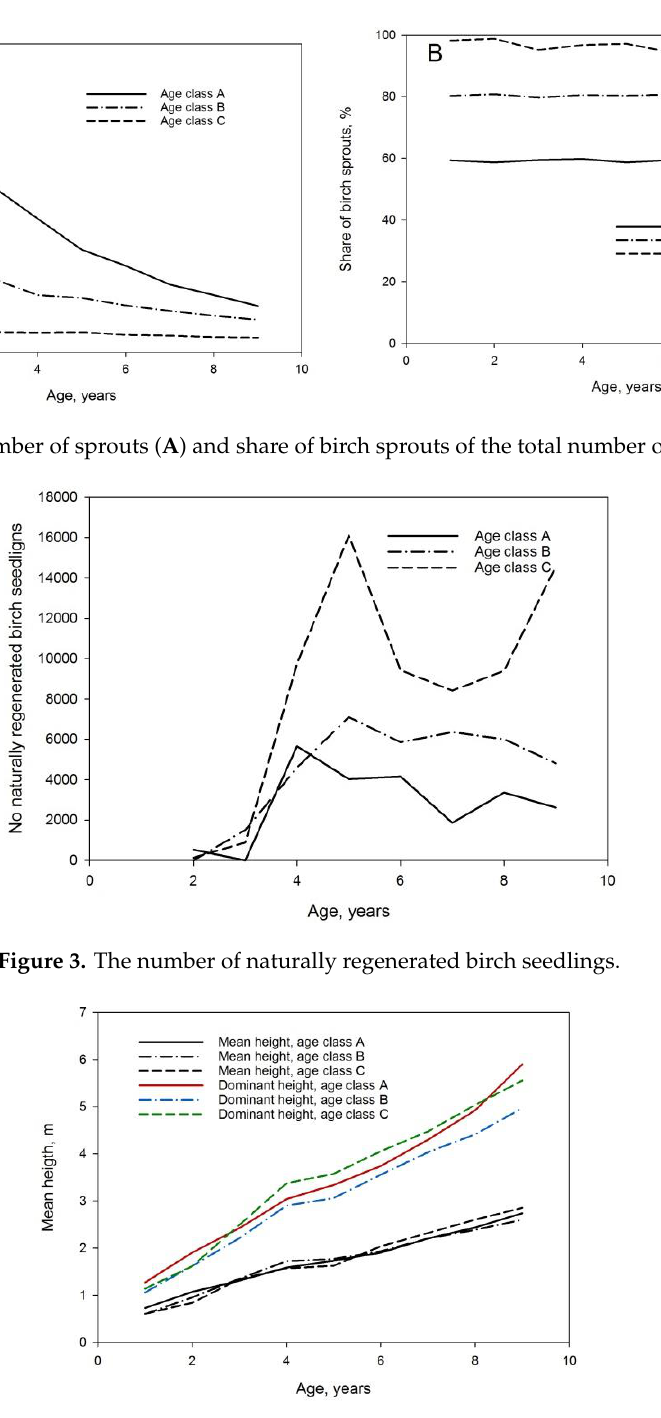
Figure 4. Mean height and dominant height of birch sprouts.